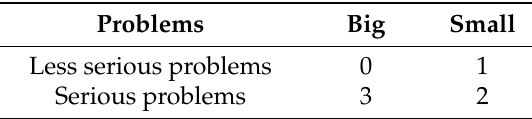
Table 2. Classification of technical